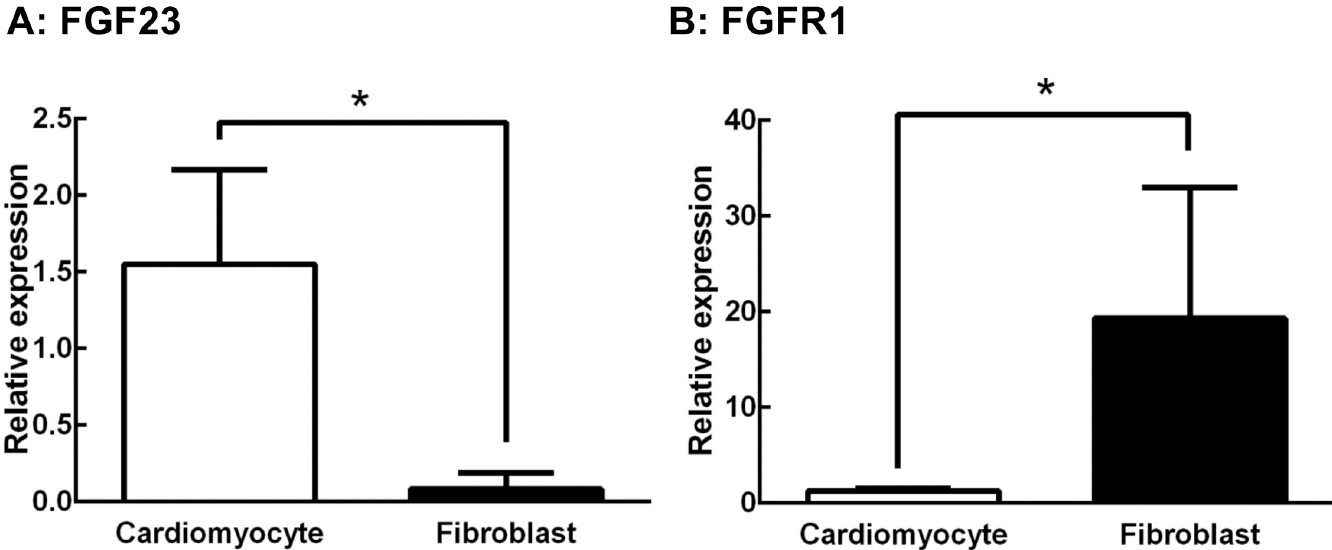
Fig 2. Relative mRNA expression levels in cardiomyocytes and fibroblasts as measured by RT-PCR. (A) Expression of FGF23. (B) Expression of FGFR1. Values are means ± SEM; n = 6 for each. ( � ) P < 0.05.